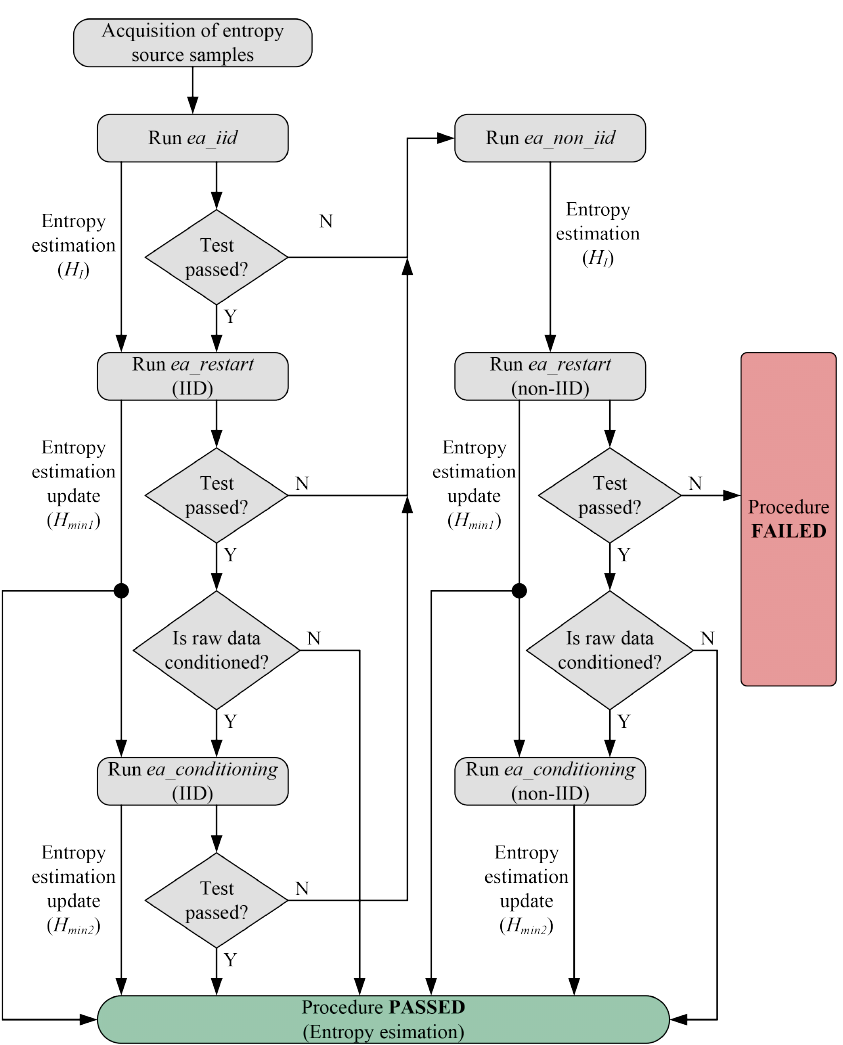
Figure 4. Flow diagram for entropy assessment when using the NIST EA